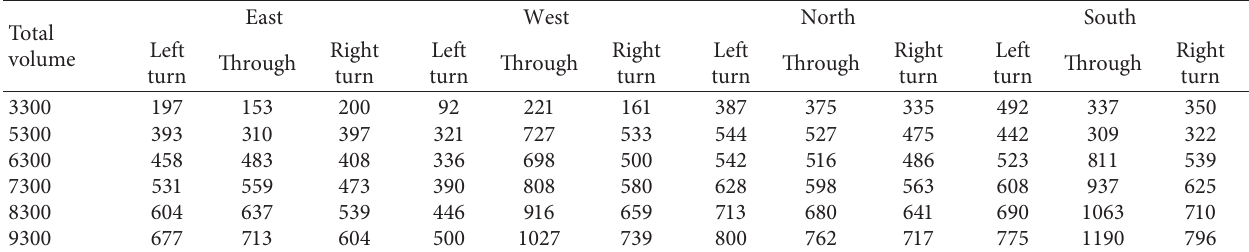
Table 3: Volume of turning movements (vph).